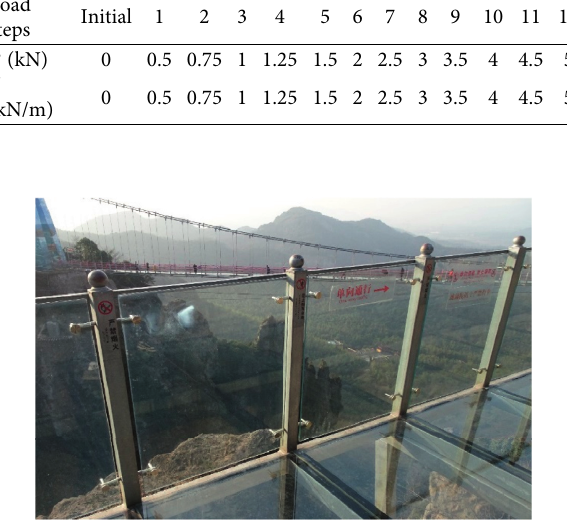
Figure 1: Example of railings constructed on